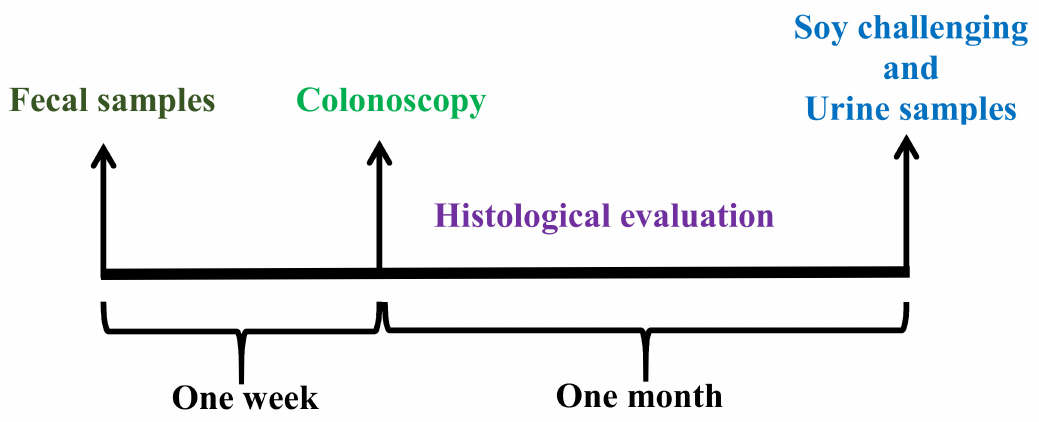
Scheme 1. The study protocol timetable.